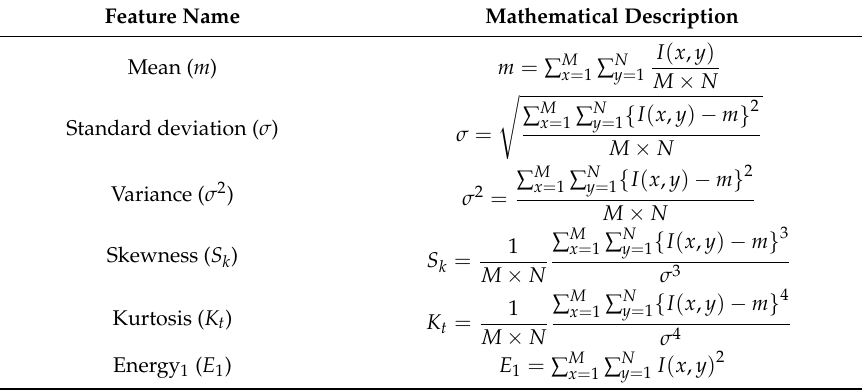
Table 2. Mathematical description of first-order statistical features.